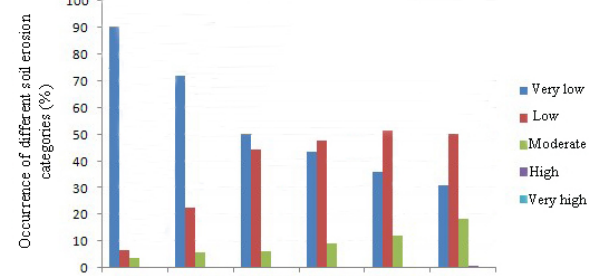
Figure 15. Characteristics of soil erosion under different land use patterns across all three study years. Figure 16. Characteristics of soil erosion under different slope gra- dient across all three study